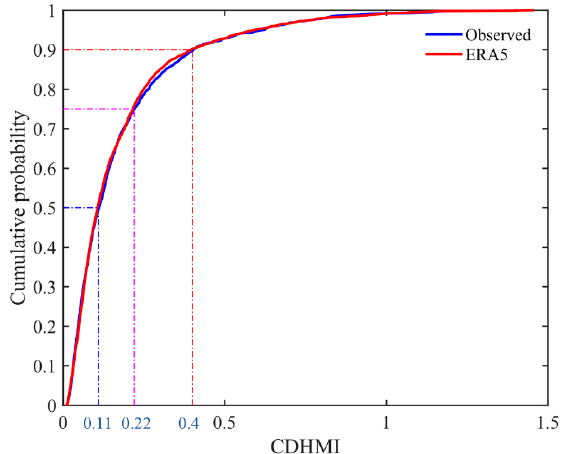
Figure 8. Empirical CDF of the CDHMI for all the CDHWs at all the stations/grids in the observa- tion/ERA5 in the GRB from 1961 to 2018.